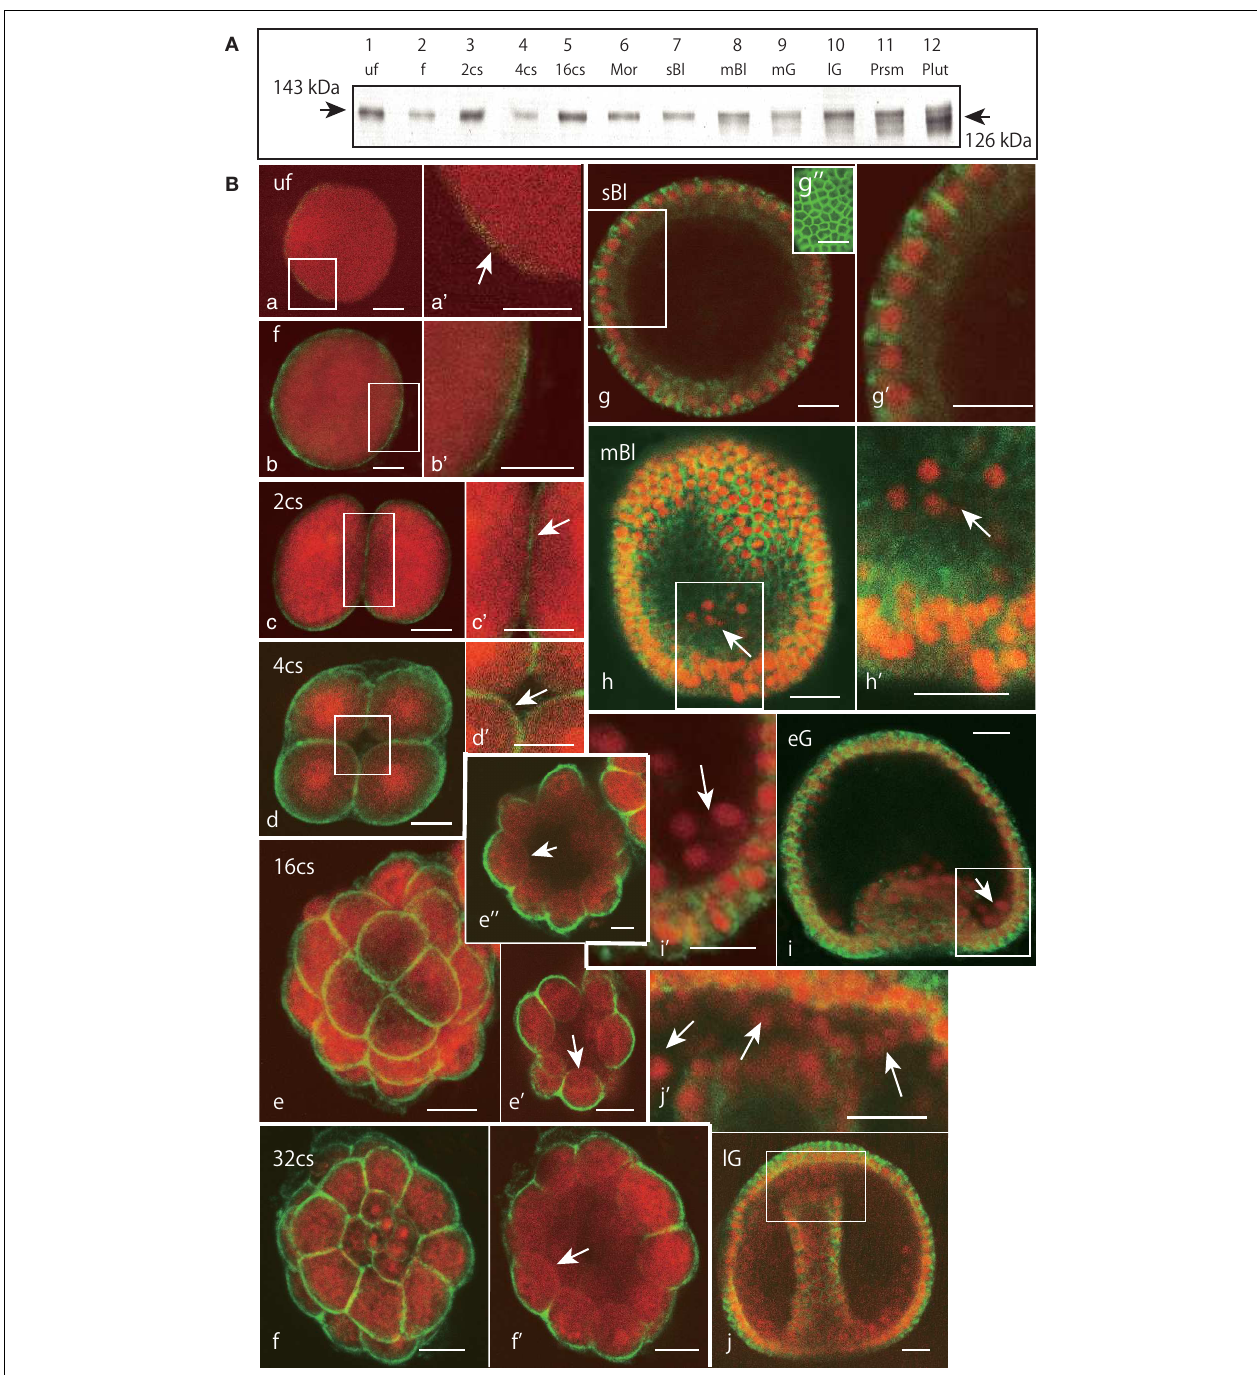
FIGURE 4 | Immunochemical expression pattern of Epith-2 during early development of H. pulcherrimus . (A) Immunoblotting pattern. Lane 1; unfertilized eggs (uf), lane 2; fertilized eggs (f), lane 3; the 2-cell stage embryos (2cs), lane 4; the 4-cell stage embryos (4cs), lane 5; the 16-cell stage embryos (16cs), lane 6; morulae (Mor), lane 7; swimming blastulae (sBl), lane 8; mesenchyme blastulae (mBl), lane 9; mid-gastrulae (mG), lane 10; late gastrulae (lG), lane 11; prism larvae (Prsm), lane 12; pluteus larvae (Plut). Epith-2 is detected consistently at the 143kDa region from unfertilized eggs to prism larvae, but a new band is detected at the 126kDa region at the pluteus stage, which replaced the larger band of relative molecular mass.